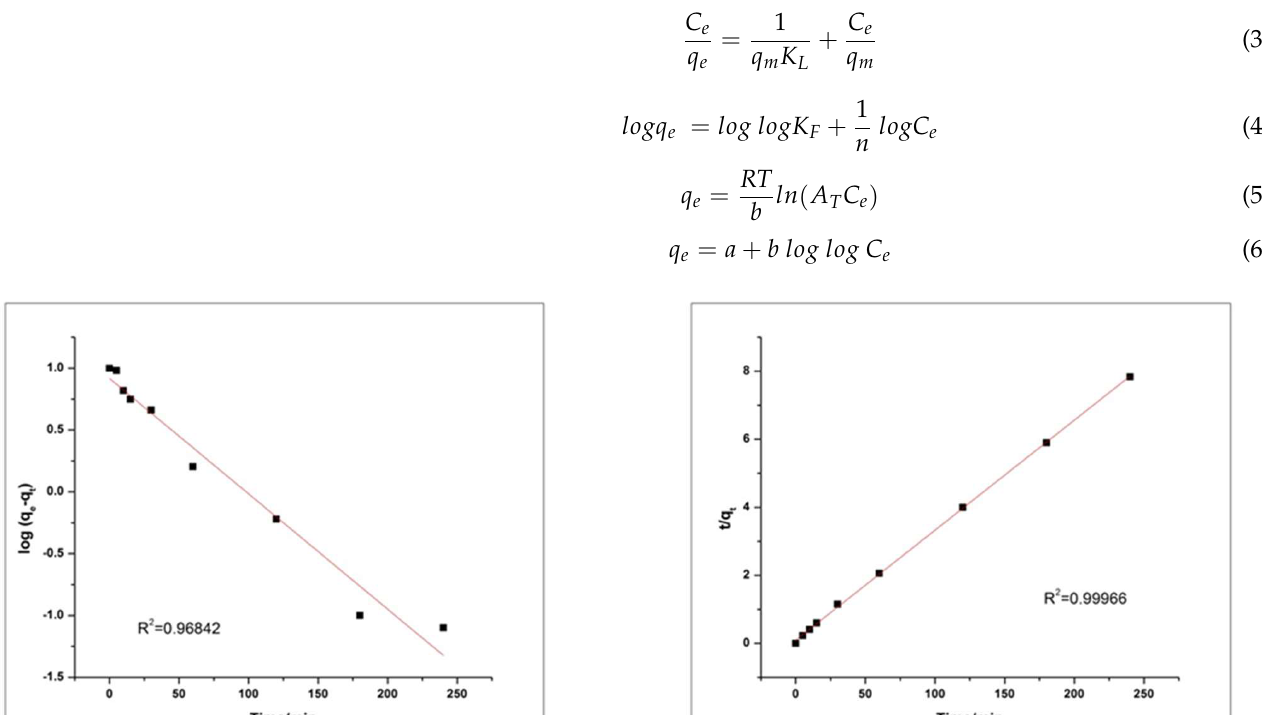
Figure 20. Pseudo first order ( left ) and Pseudo second order ( right ) kinetic plot for MO.